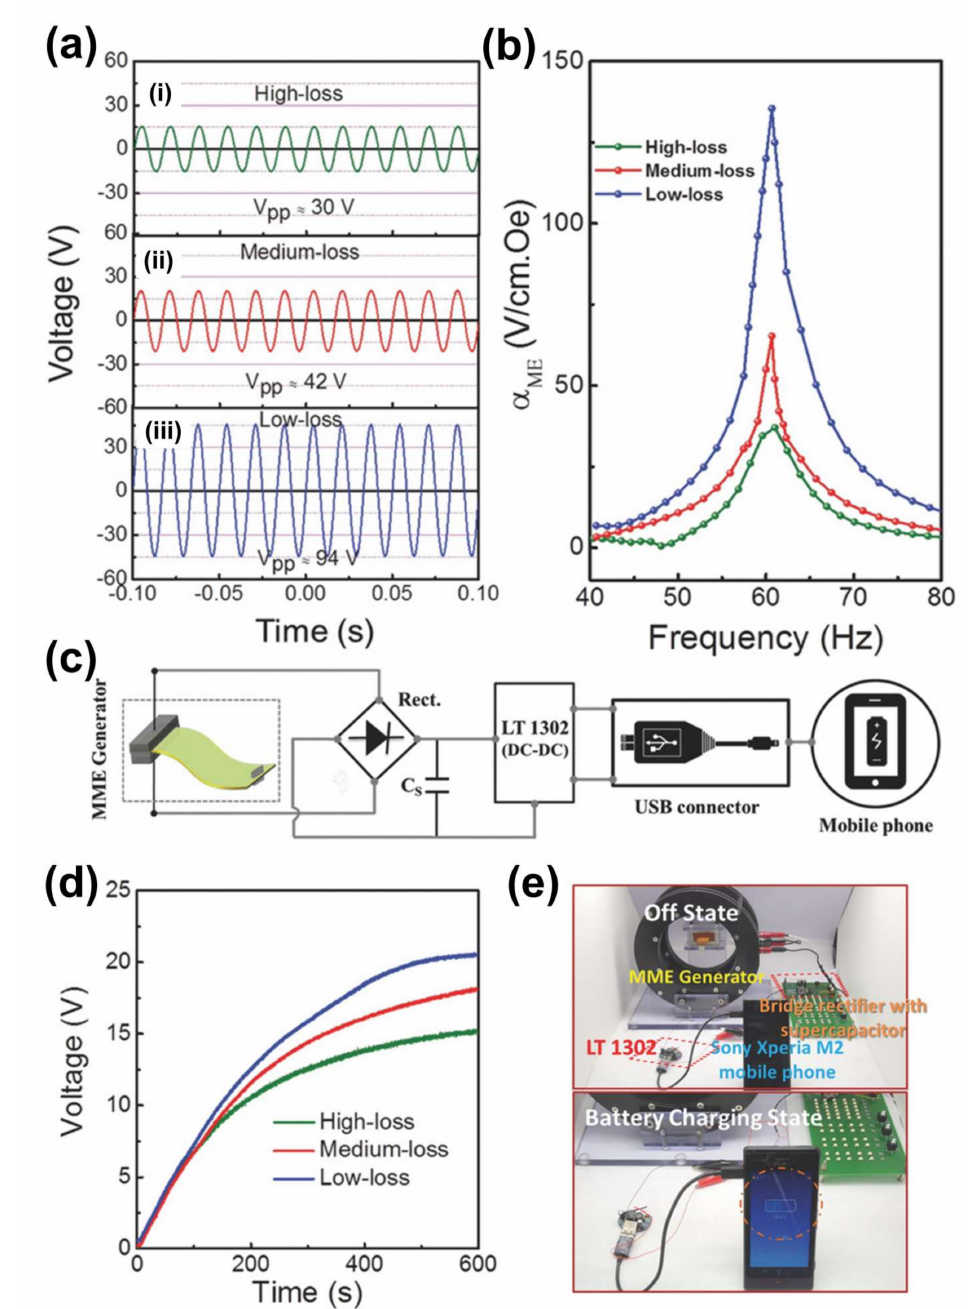
Figure 5. ( a ) Generated voltage from signals from high − loss, medium loss, and low − loss based MME generators. ( b ) ME voltage coefficient ( α ME ) as a function of HAC driving frequency for various MME generators. ( c ) Schematic diagram of self-powered electric system for charging mobile phone battery using MME generator. ( d ) The charging response in 2.2 mF supercapacitor for various generators. ( e ) Off and on state charging phone battery. Reproduced with permission